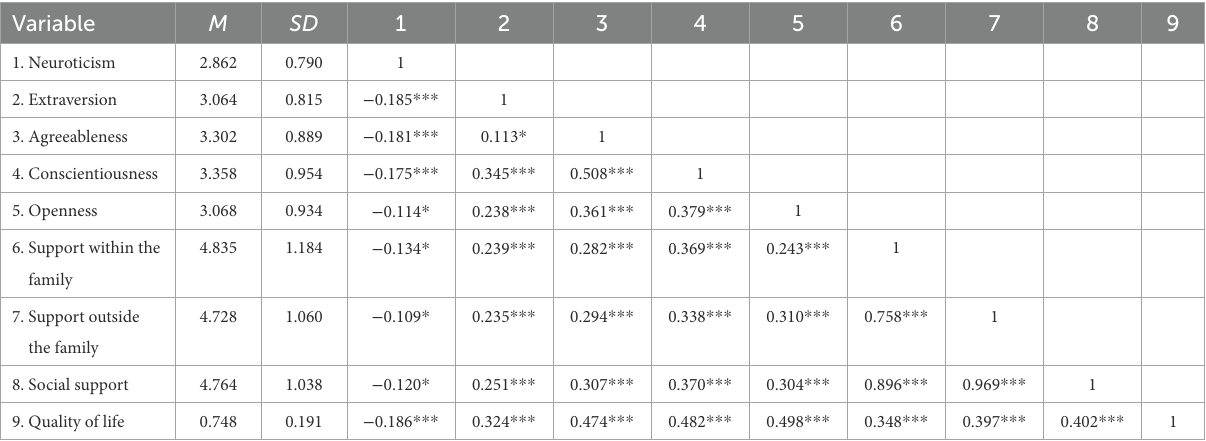
TABLE 2 Correlations, means, and standard deviations of all study